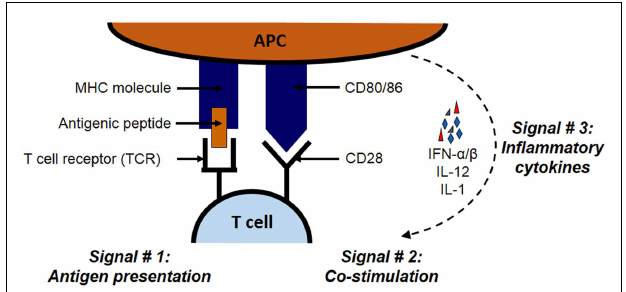
FIGURE 1 |The three signals necessary for the stimulation of antigen-specificT cell .The priming of antigen-specificT cell requires three signals: antigen, co-stimulation, and cytokines. Antigenic proteins undergo antigen processing and then the peptides are presented through MHC class I or II molecules for CD8 and CD4T cells, respectively.The second signal in the form of co-stimulation is provided by molecules such as B7 family member proteins such as B7.1 (CD86) and B7.2 (CD80) expressed on APCs.These B7 proteins interact with their receptors such as CD28 on interactingT cells. Inflammatory cytokines such as IFN- α / β , IL-12, and IL-1 constitute the third